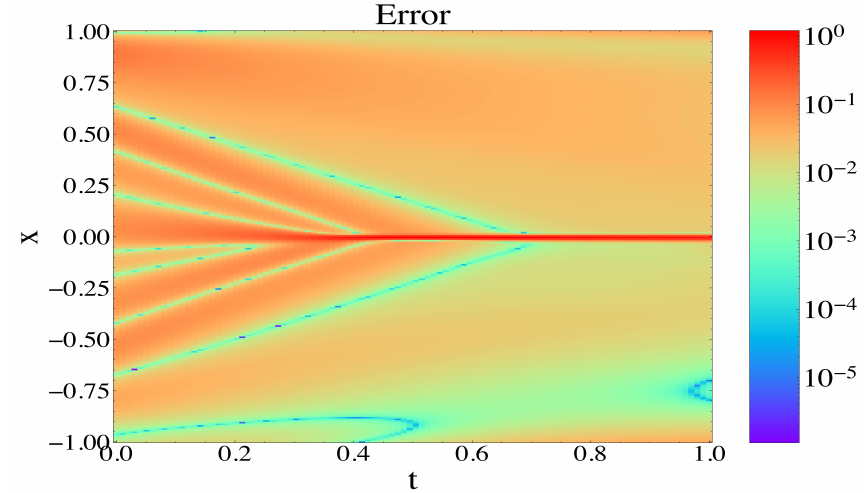
Figure 12. Burgers equation with data noise: Error contour